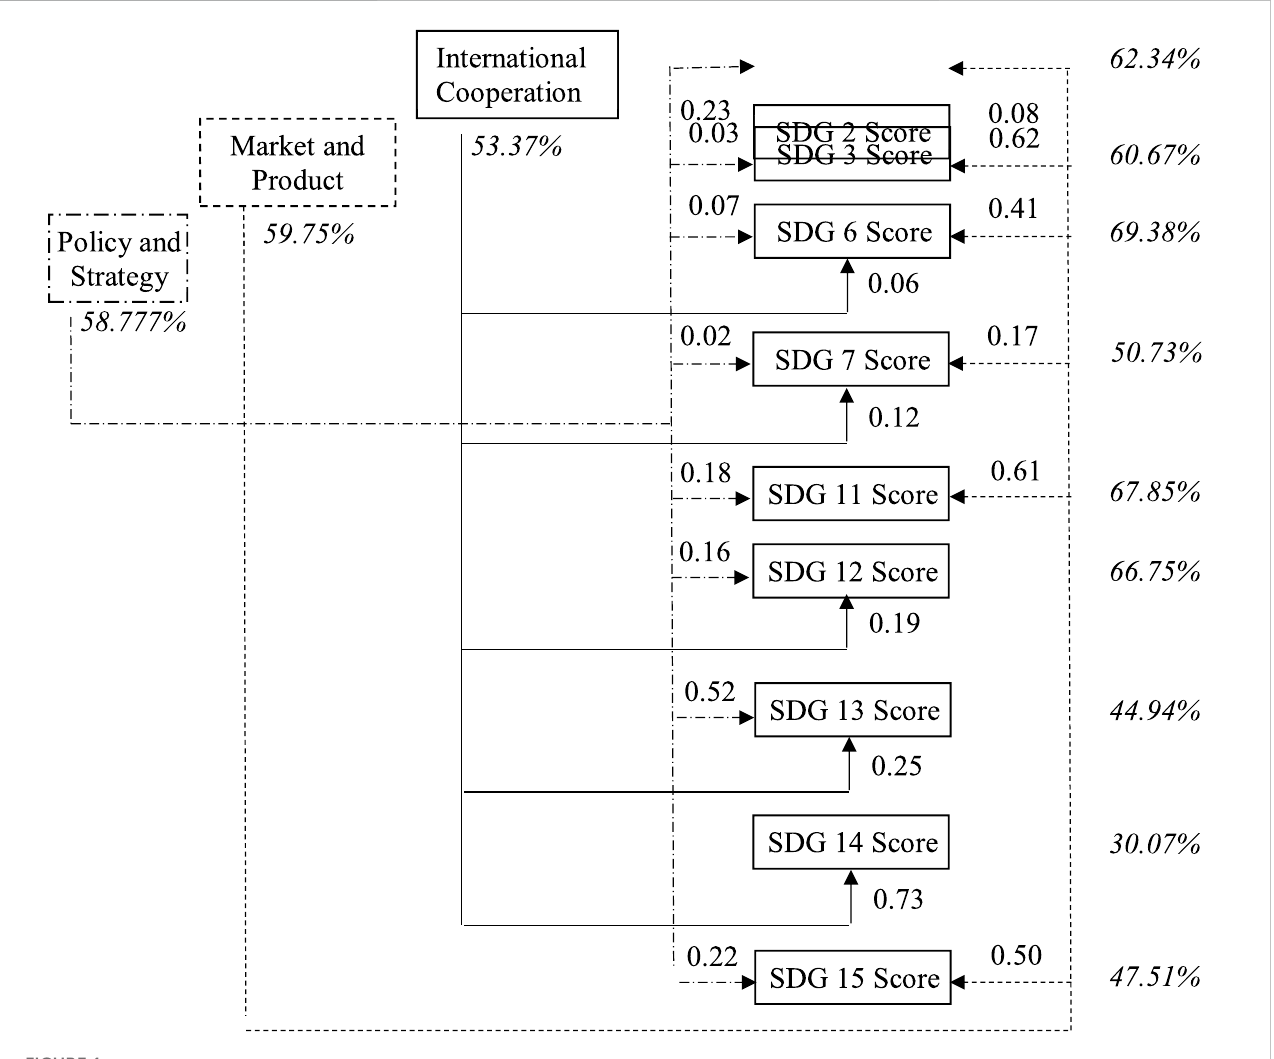
FIGURE 1 SEM model of the impact of green fi nance on the economy and environmental managementin